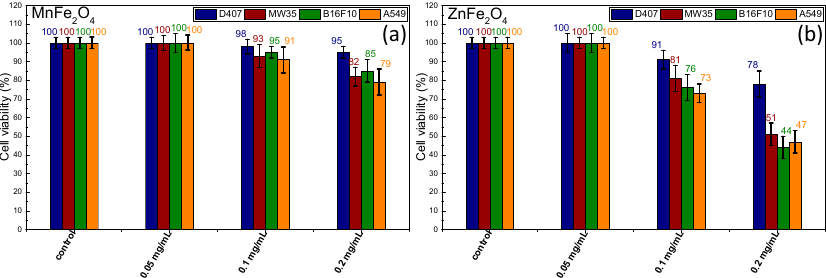
Figure 4. Cell viabilities exhibited by the four cell lines exposed to ( a ) manganese ferrite and ( b ) zinc ferrite MNPs (mean ± (SEM), n = 3) for three di ff erent